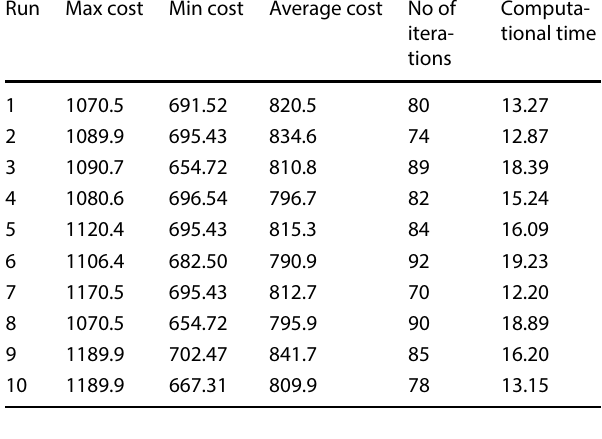
Table 3 statistical fitness results for ventilator manifold problem